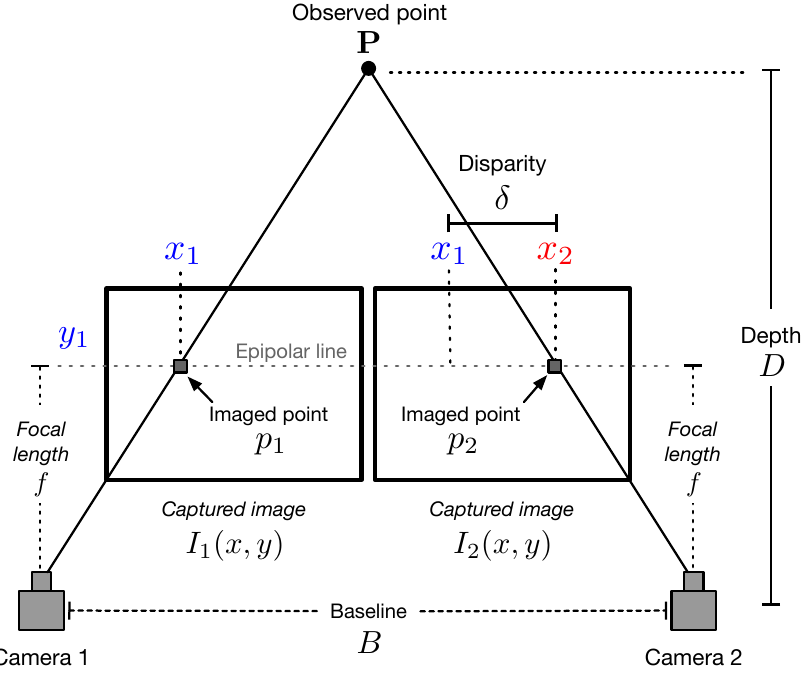
Figure 1. Description of a stereo imaging